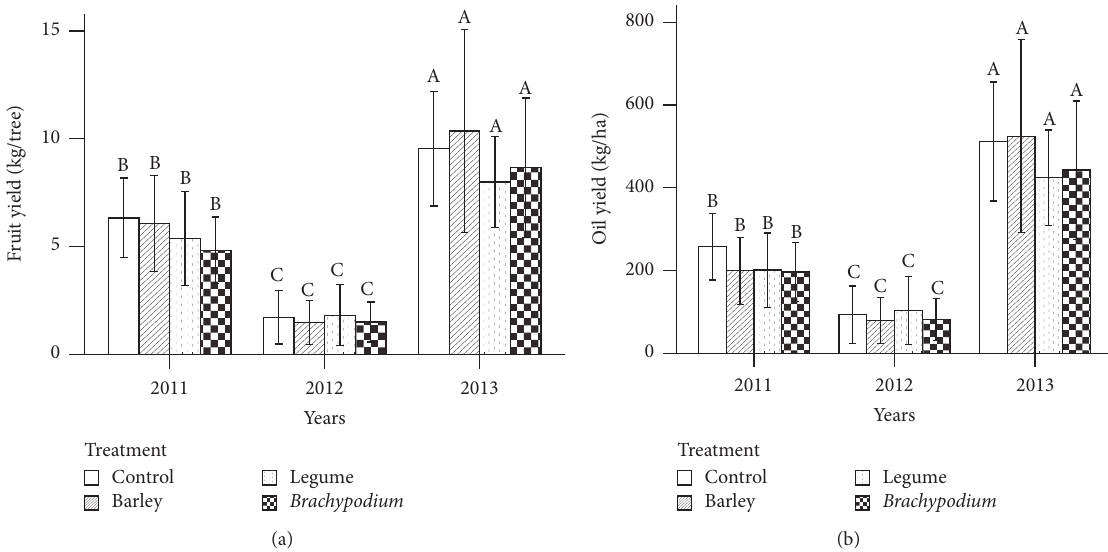
Figure 3: Fruit yield (a) and oil yield (b) mean and SD for the three years. Data are means of 10 replicates. Different letters mean statistically significant differences ( 𝑝 < 0.05 ) among